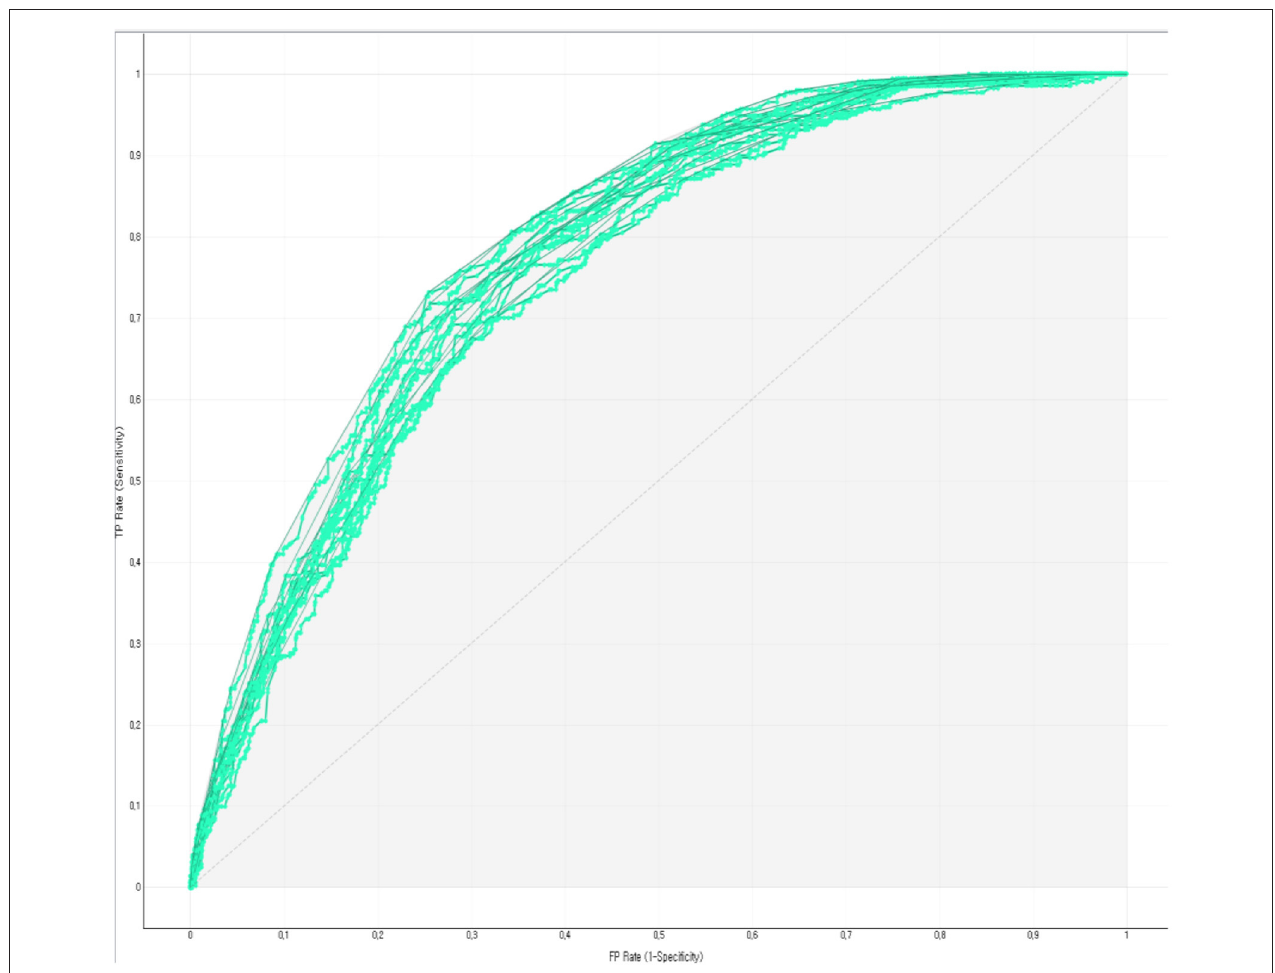
FIGURE 8 | ROC of the Bayesian nomogram for predicting the depressive disorders of female older adults living alone.